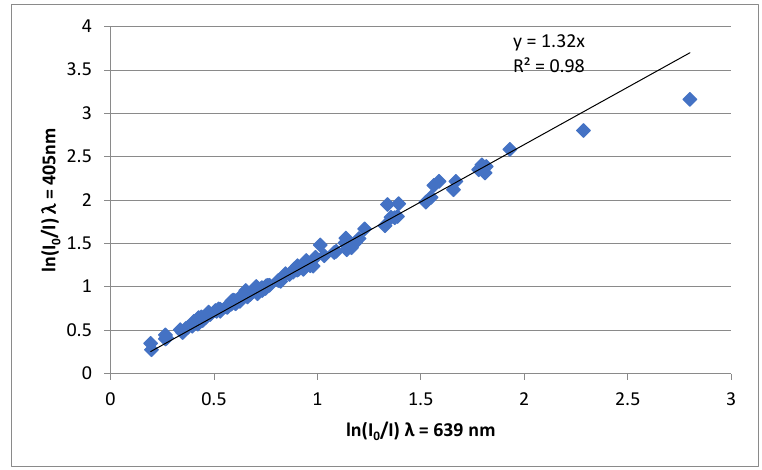
Figure 1. The plot of ln( I 0 / I ) for λ = 405 nm versus ln( I 0 / I ) for λ = 639 nm, where (cid:16) (cid:17) λ 2 = 1.32, and ε ( λ ) = 7.97 m 2 g − 1 for the sampling from the Krakow site. gradient 405 λ 1